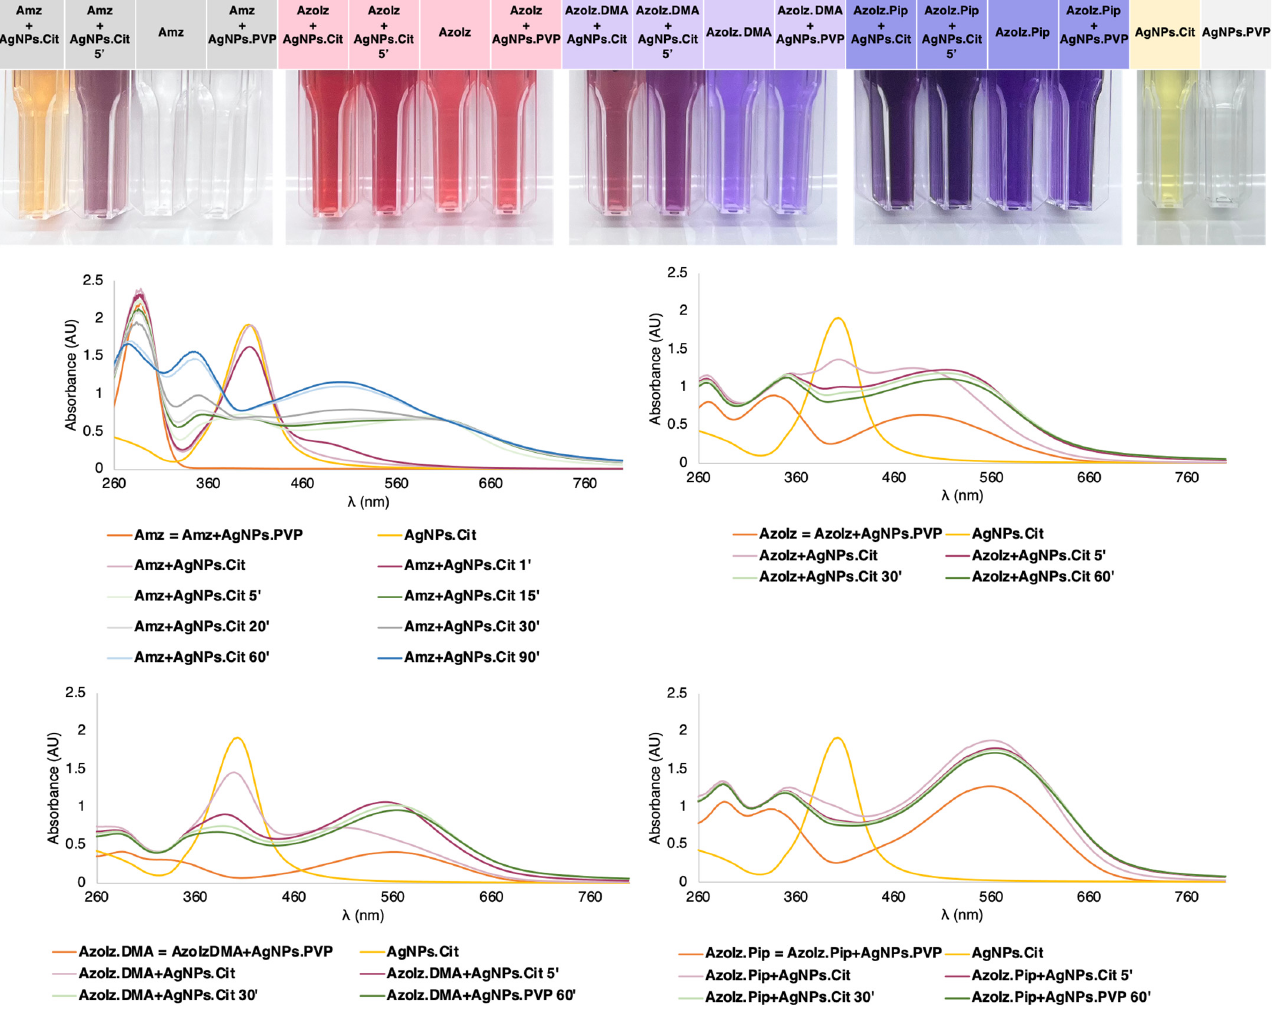
Figure 3. Colors of the dispersions after conjugation of Amz/AzoIz with AgNPs, corresponding controls, and UV–vis spectra.